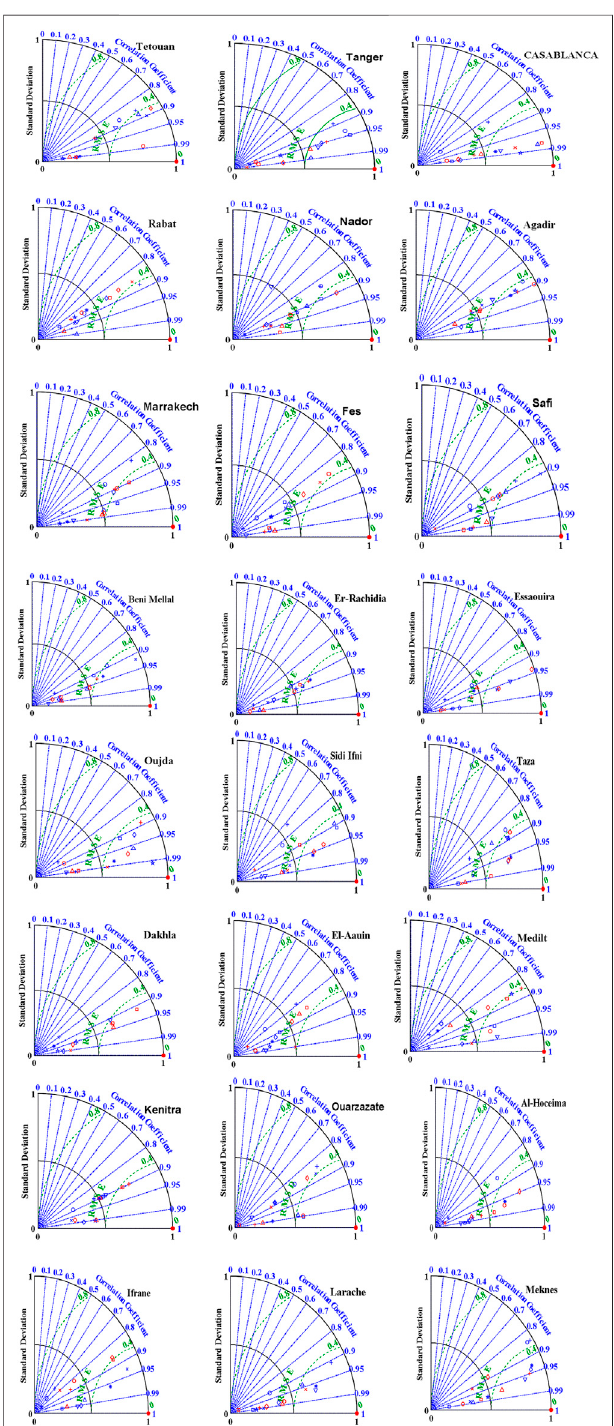
FIGURE 7 | Taylor diagrams of twenty- fi ve study locations in